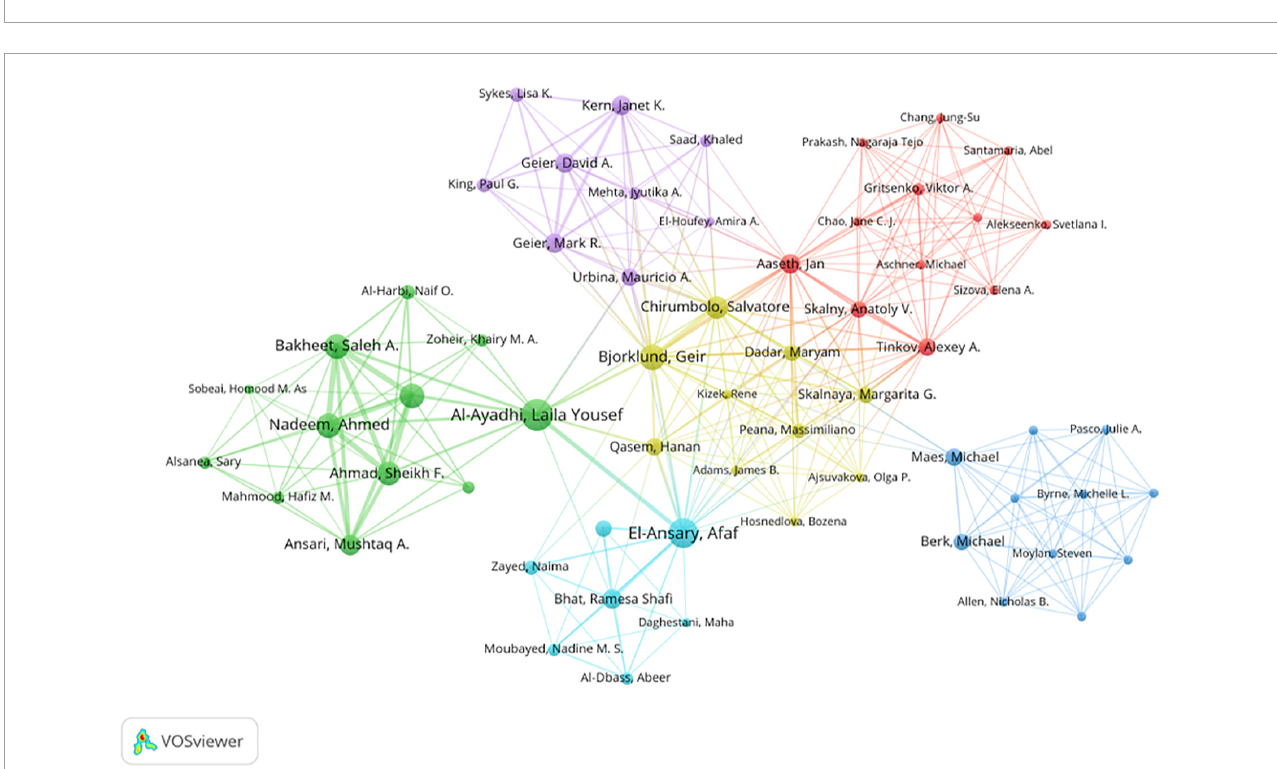
FIGURE6 The cooperation network visualization map of authors based on VOSviewer: The node size represents the number of articles published by the author, and the different color blocks represent different academic groups.